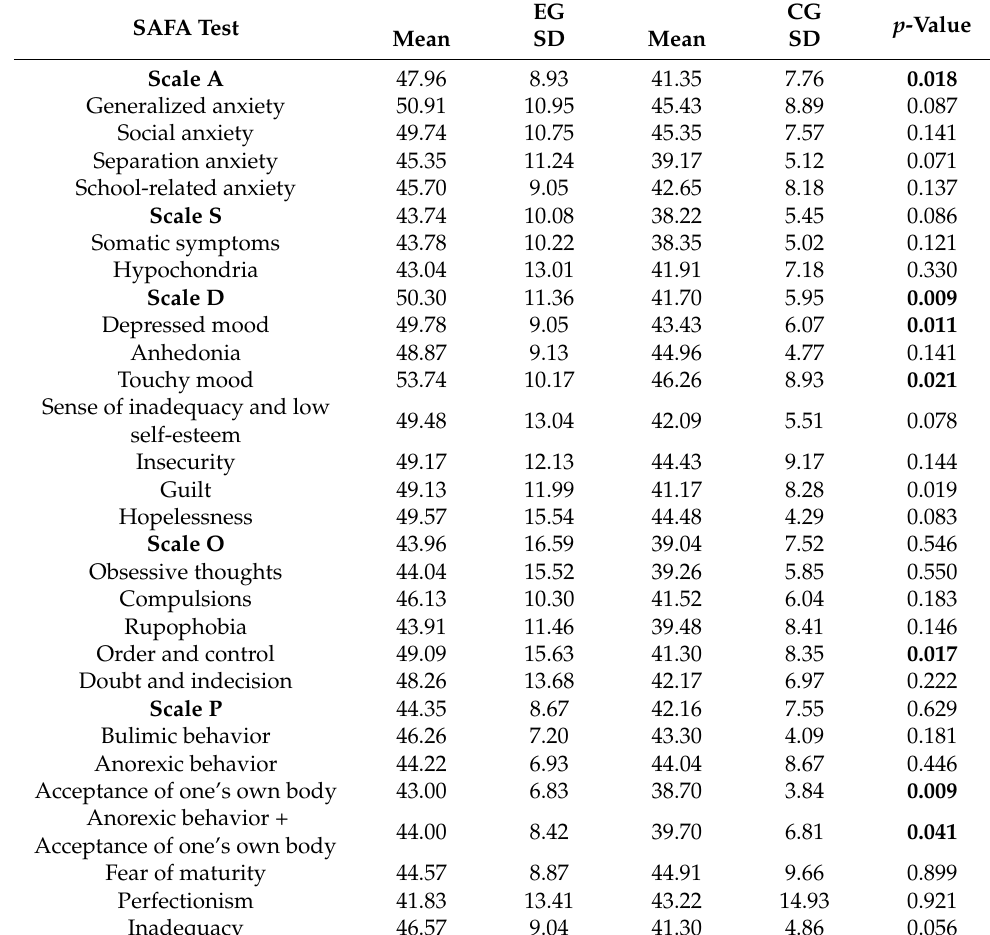
Table 4. Comparison of the SAFA domains between EG and CG.